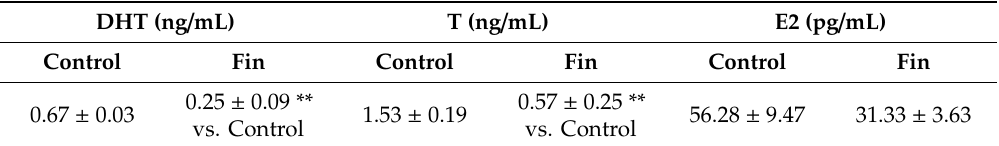
Table 1. Dihydrotestosterone (DHT), testosterone (T), and estradiol (E2) concentrations in control and finasteride-treated mature rat blood serum. DHT (ng / mL) T (ng / mL) E2 (pg / mL) Control Fin Control Fin